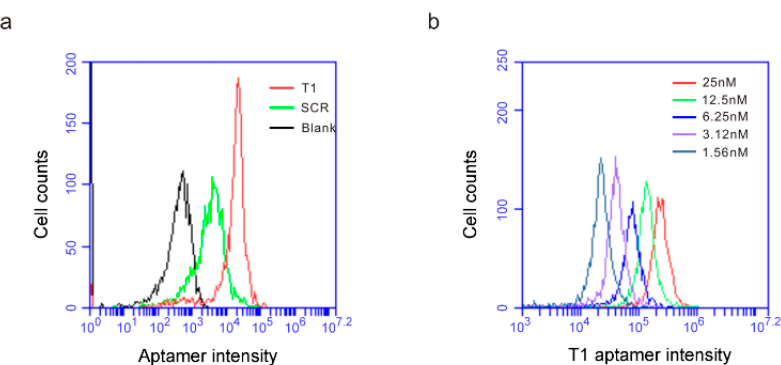
Figure 4. T1 aptamer preferentially binds human bone marrow cells. ( a ) Human bone marrow cells were incubated with increasing concentrations of Cy5-labeled T1 or SCR aptamers, and flow cytometry was performed to detect aptamer-binding cells. ( a ) Separation of scramble- and T1 aptamer-binding human bone marrow hematopoietic cells. Aptamer concentration: 1.56 nM. ( b ) T1 aptamer concentration-dependent binding of human bone marrow hematopoietic cells.